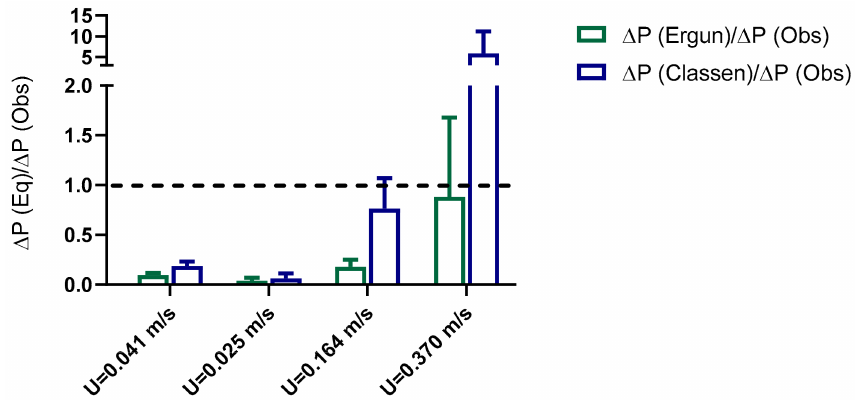
Figure 3. Comparison of pressure drop predicted using equation by Ergun [37] and Classen et al. [38] to observed values.